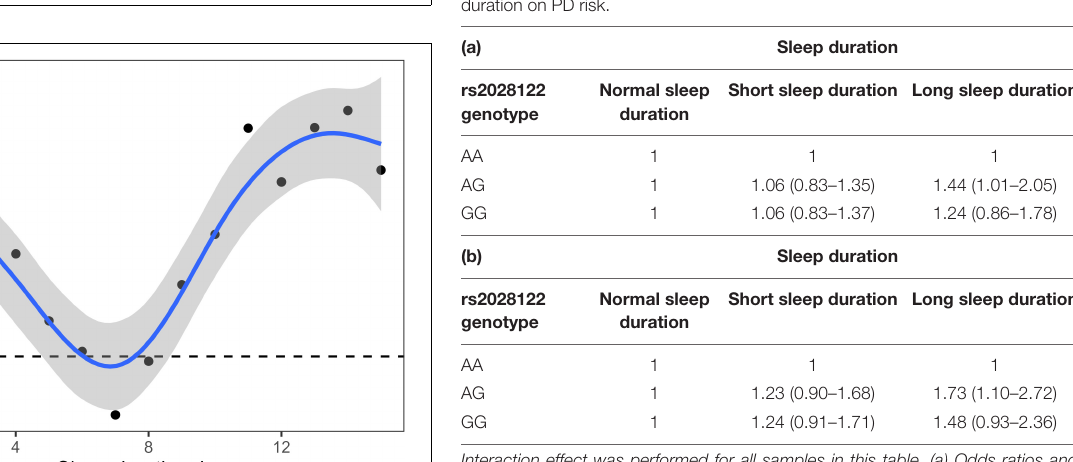
FIGURE 1 | Prevalence of PD across a different sleep length spectrum. Each node represents the prevalence of PD of the corresponding sleep duration. This figure shows a curvilinear U-shaped correlation of sleep duration with prevalence of PD for AA carriers (blue line), AG carriers (red line), GG carriers (purple line), and total subjects (green line). PD, Parkinson’s disease.